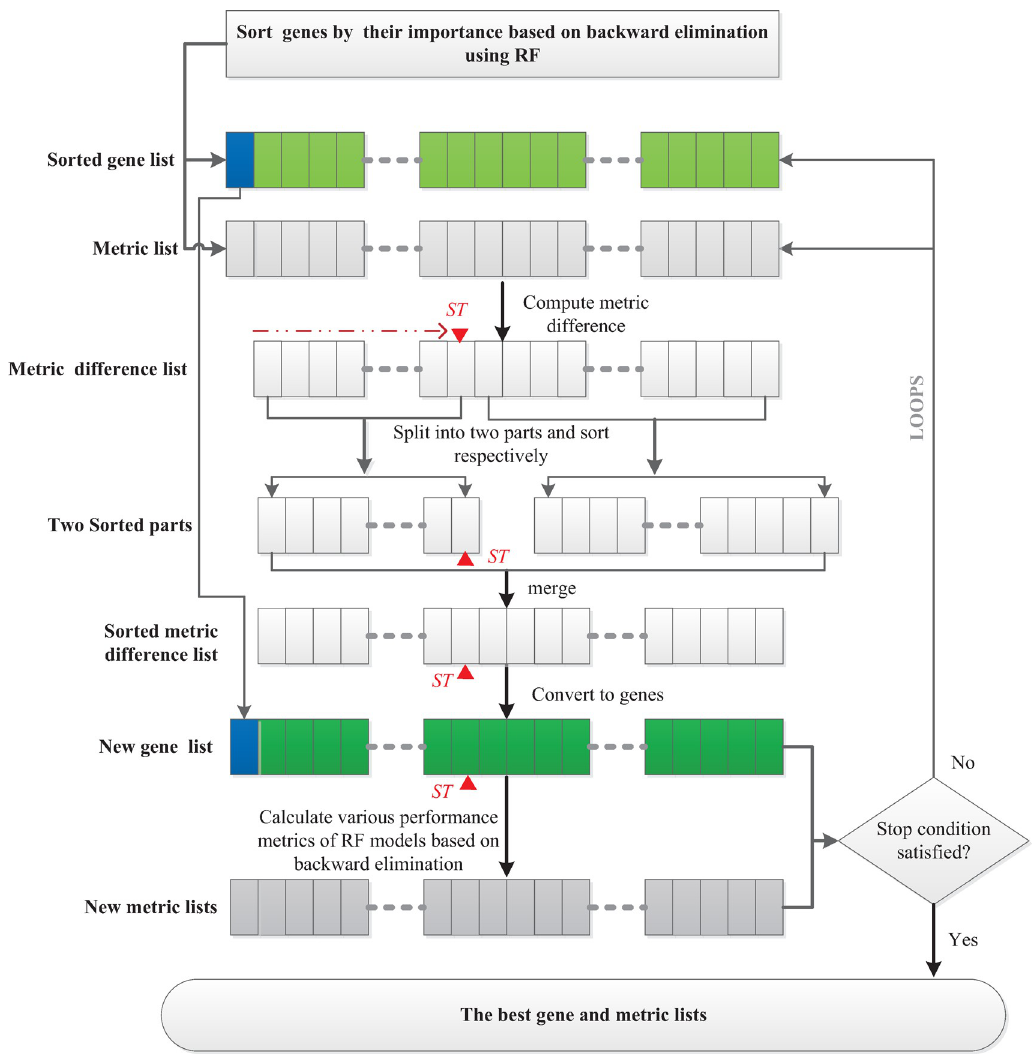
Fig 1. Procedure of the Sort Difference Backward Elimination (SDBE)